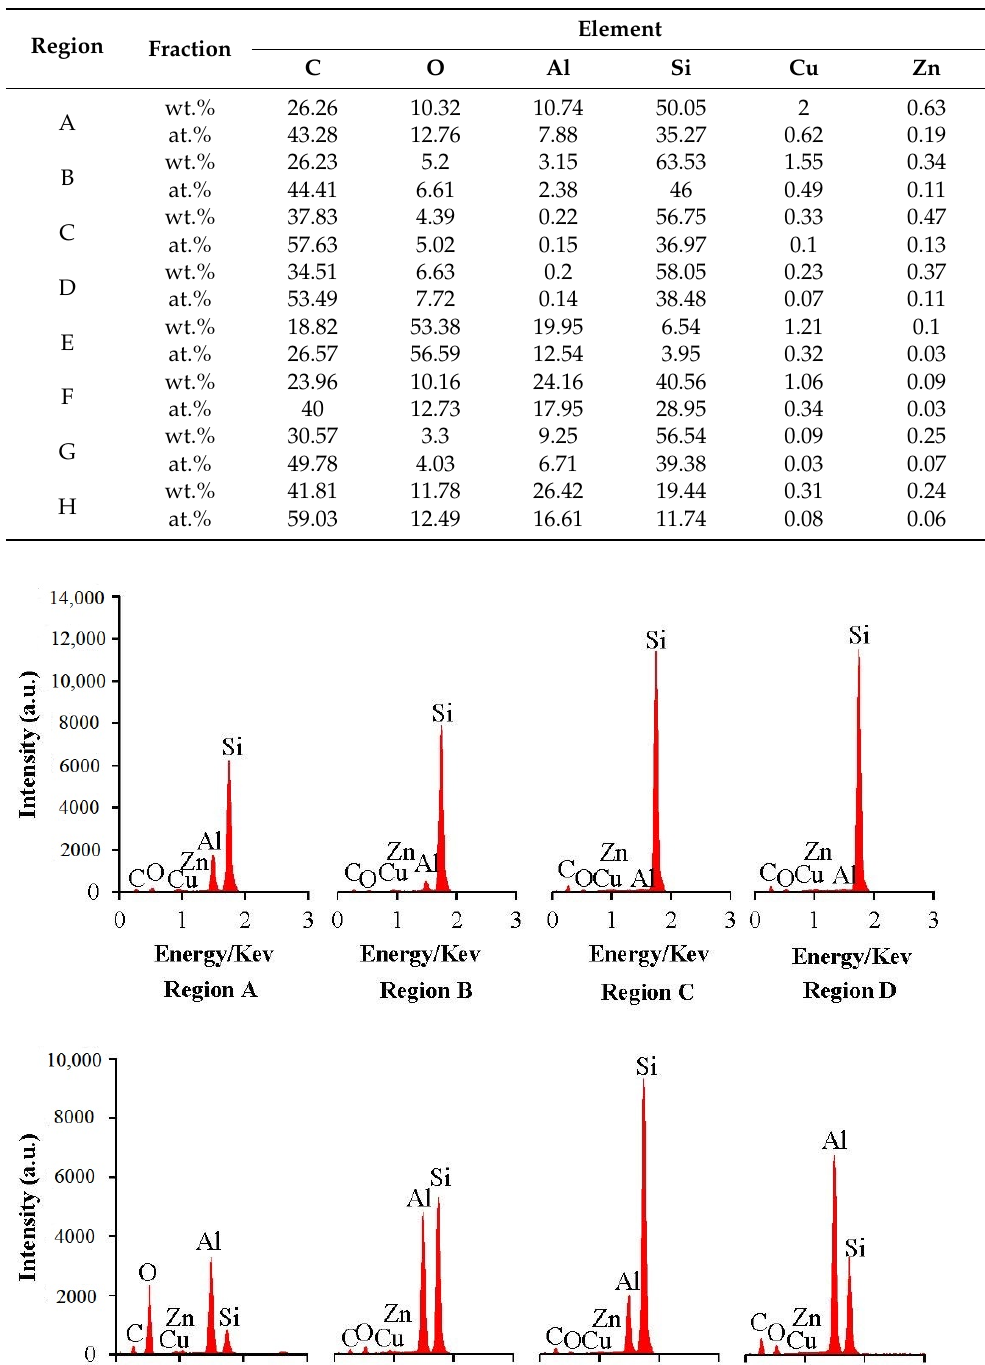
Table 6. Chemical composition of the workpieces surface. Region